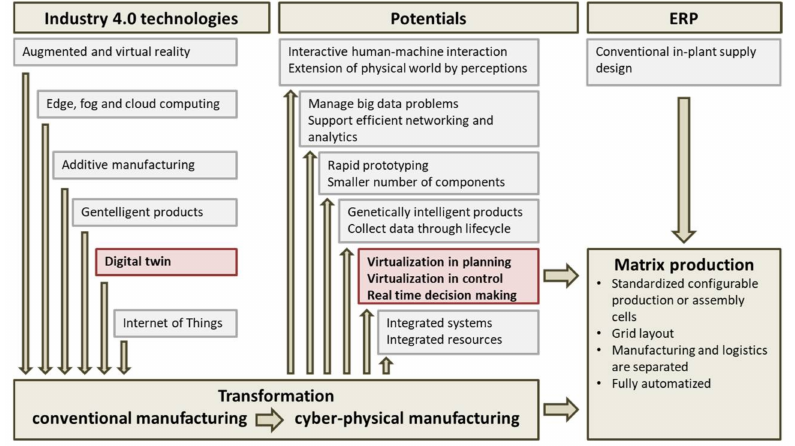
Figure 1. Industry 4.0 technologies as new innovation accelerators and their impact on matrix